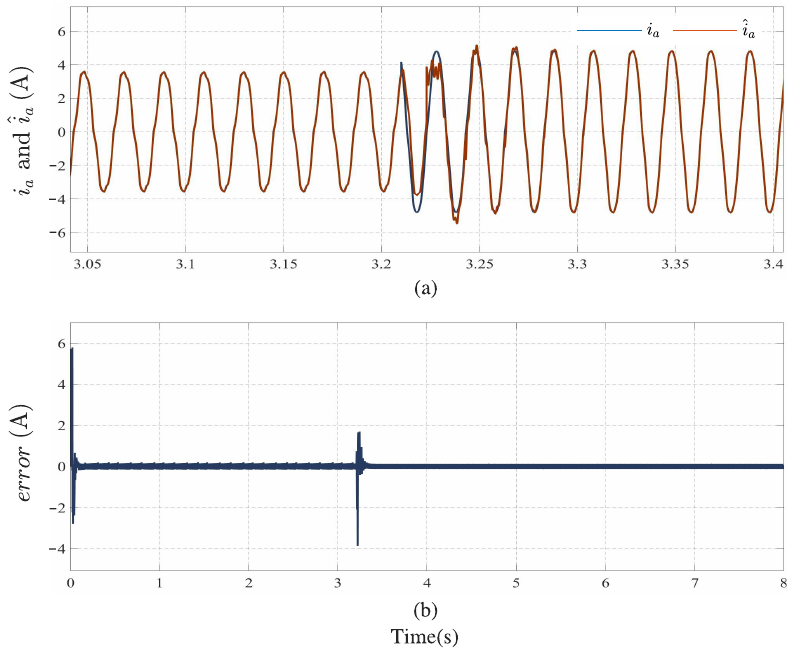
Figure 17. Experimental results: ( a ) comparison between ˆ i a and i a . ( b ) Error current.